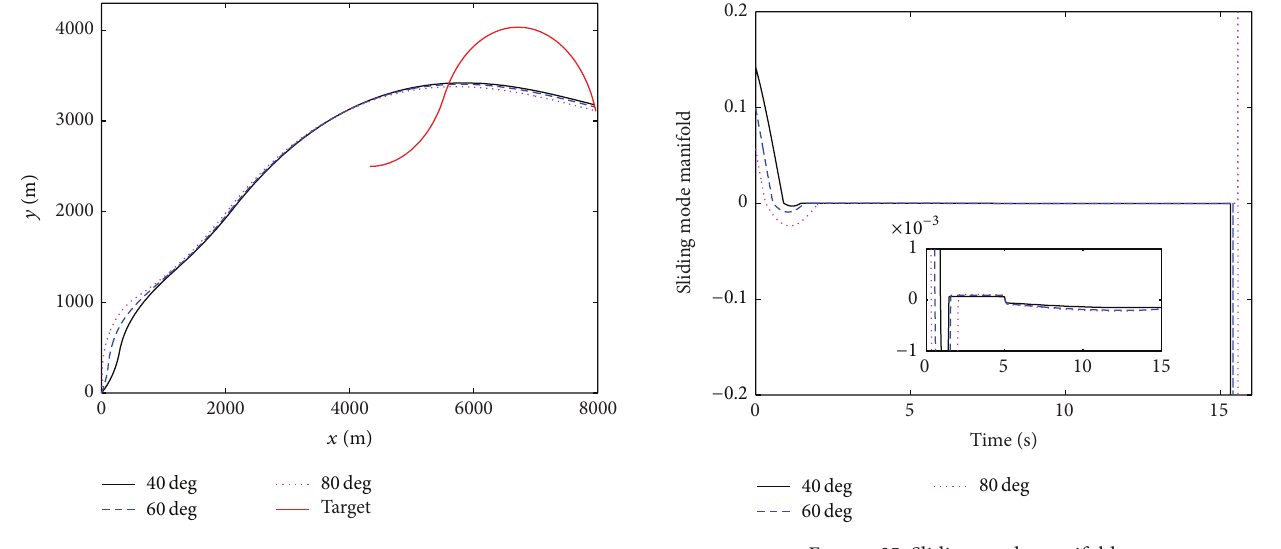
Figure 33: Trajectories of missile and target.